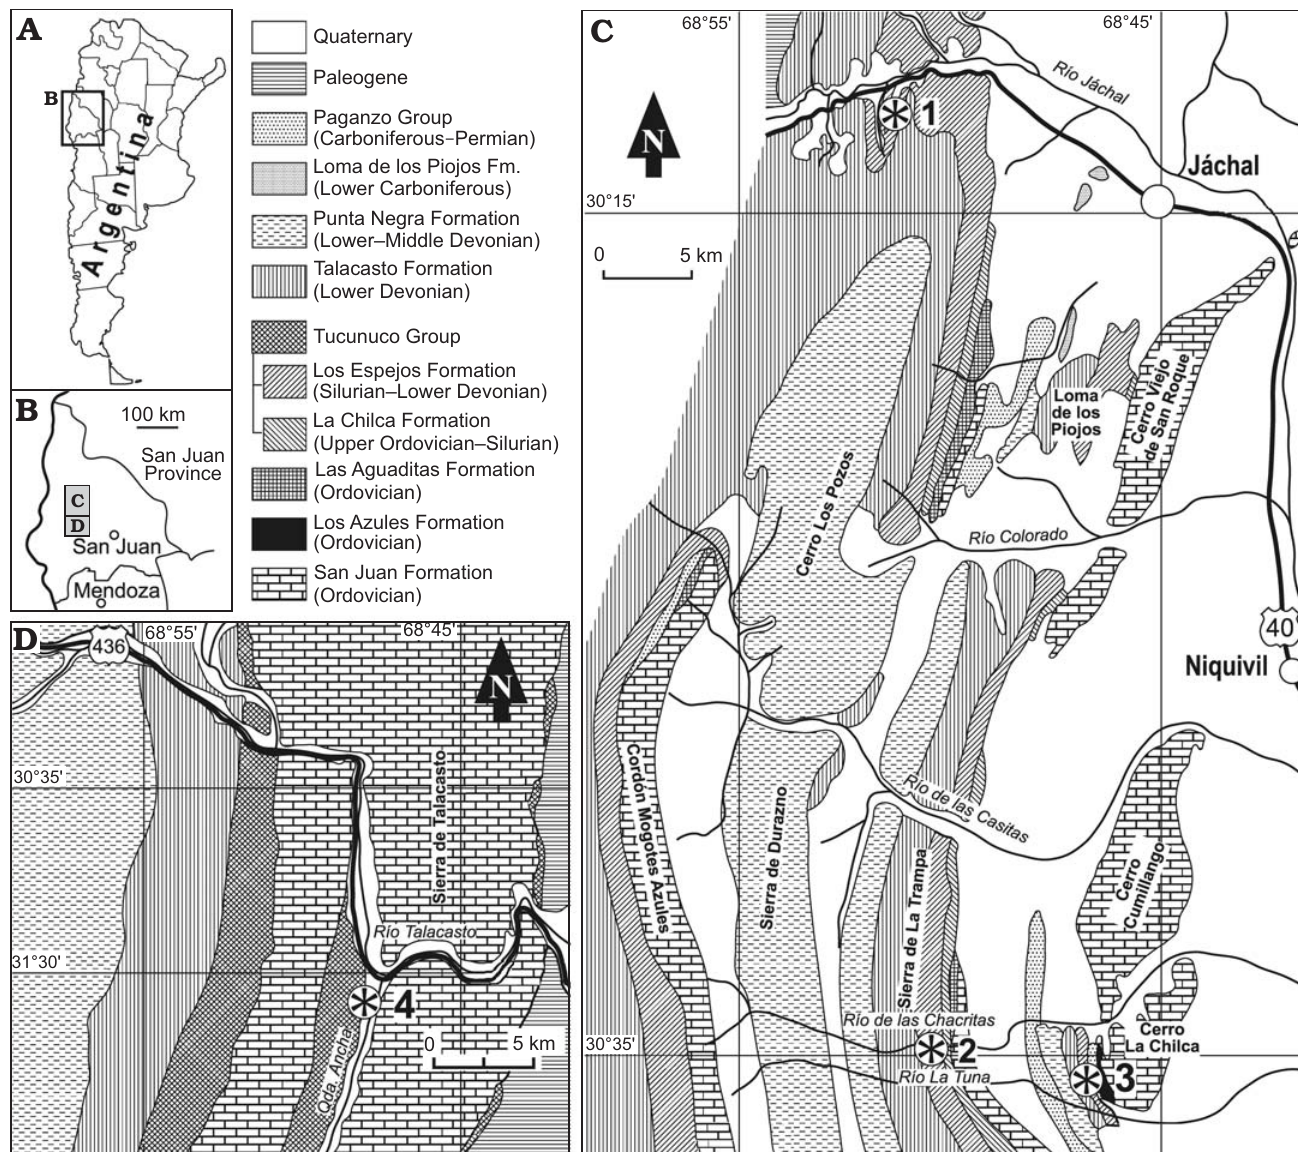
Fig. 1. A , B . Geographic location of study areas. C , D . Geologic maps showing the fossil localities (asterisks). The northern and middle ( C ) and southern ( D ) part of the Silurian–Devonian Basin. 1, Río Jáchal; 2, Río de las Chacritas; 3, Cerro La Chilca (this paper); 4, Quebrada Ancha (this